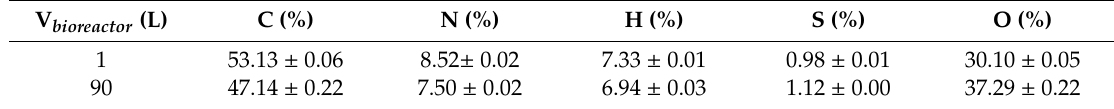
Table 8. Elemental analysis for the biomass cultivated on di ff erent